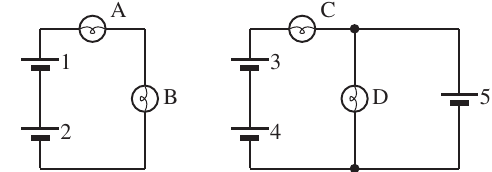
FIG. 5. Circuit diagrams used in the multiple batteries in multiple loops pretest. Students are asked to rank the bulbs by brightness.